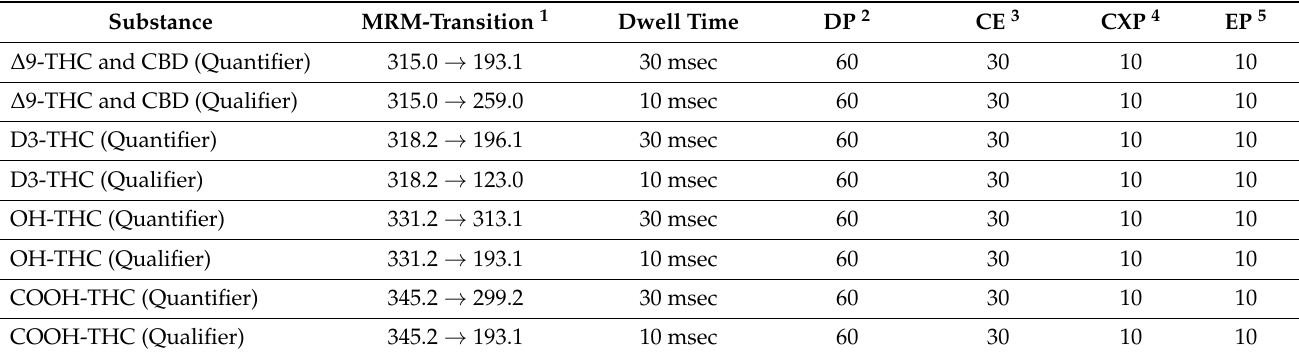
Table 1. LC-MS/MS mass transition and